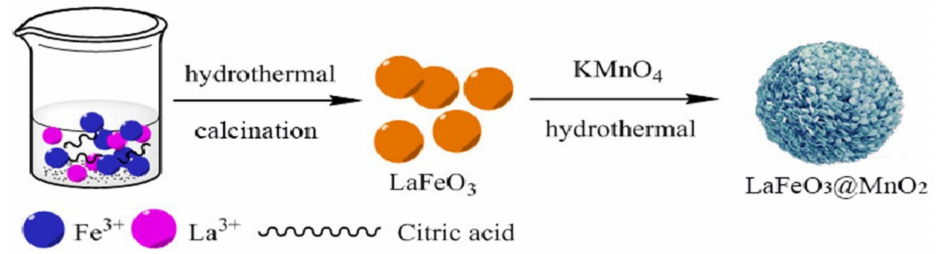
Figure 8. Synthetic routes of LaFeO 3 and LaFeO 3 @MnO 2 . Reproduced with the permission of ref. [59]. Copyright 2020, Advanced Powder Technology.